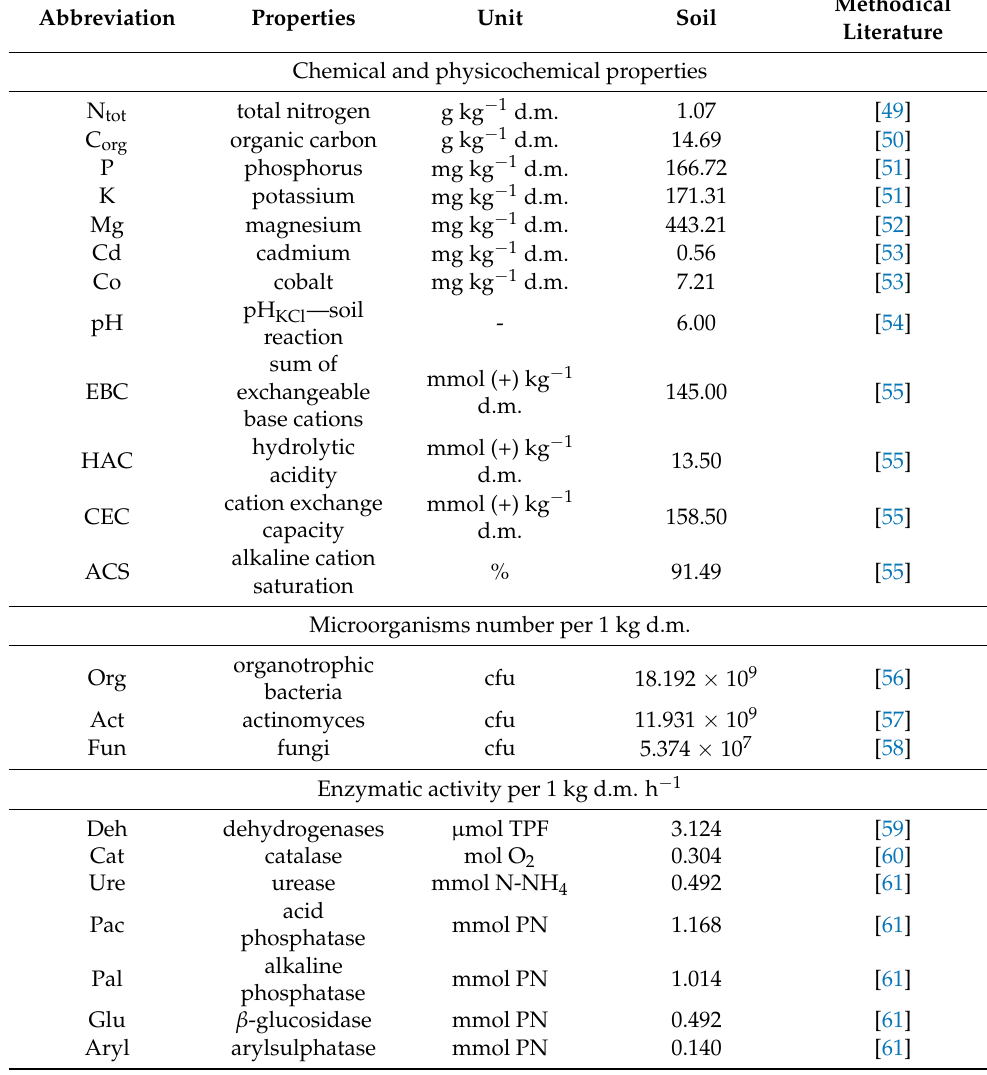
Table 1. Some properties of the soil and compost used in the